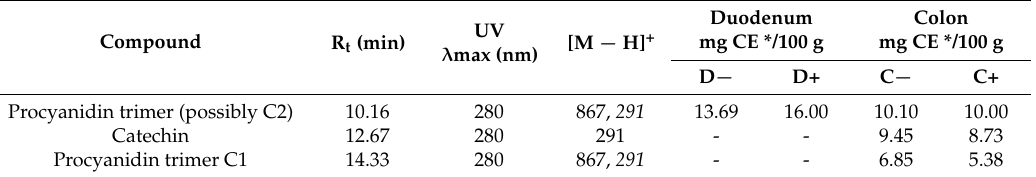
Table 6. Phenolic profile and phenolic compounds content (mg CE/100 g) in duodenum, (D+ and D − ) and colon (C − and C+) samples evaluated by LC-MS.